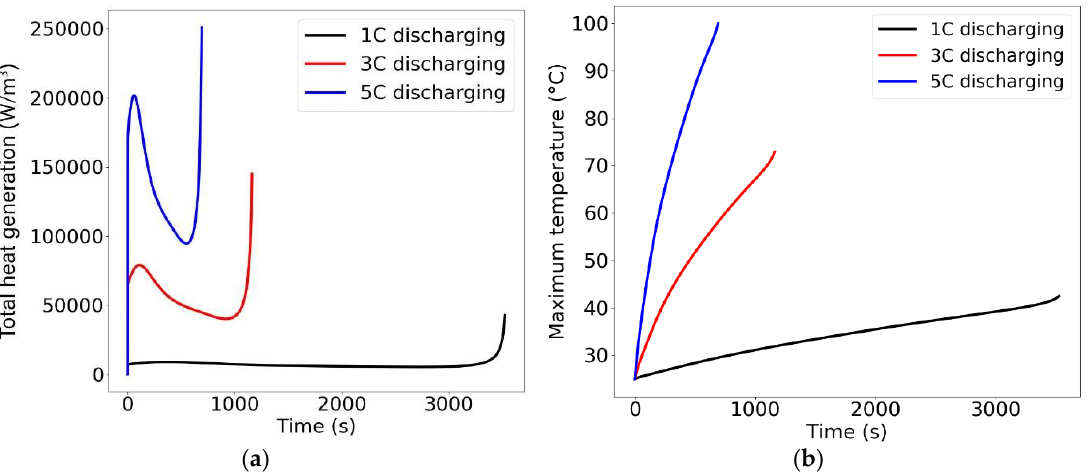
Figure 6. Curve histories at various C-rates of the battery module in the conjugate simulation: ( a ) average volume heat generation and ( b ) maximum temperature.